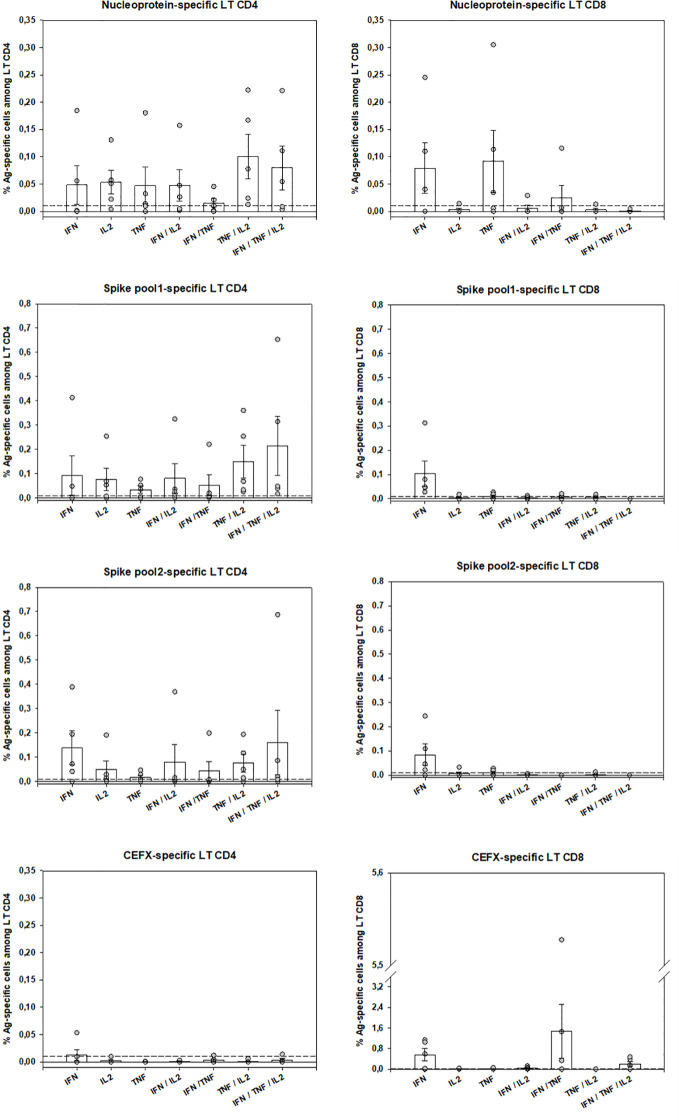
SARS-CoV-2–specific-T-cells numbers and functions. Peripheral antigen-specific CD4 and CD8 T-cells from 5 patients were identified by intracellular staining of IFN-κ, TNF-α and IL-2 by flow-cytometry as described (see Material and Methods and Suppl. Methods sections). Shown are individual data from stimulation with SARS-CoV-2 Nucleoprotein and Spike Glycoprotein peptides pools as well as by multiple immunodominant microbial peptides (CEFX pool) for CD4 and CD8 T-cells and for each cytokine capability (monofunctional, bifunctional or trifunctional). Basal cytokine production of medium-stimulated cells was subtracted for each antigen-stimulated cell subtype and a 0.01% positivity threshold was defined (dotted lines). Bars are shown as mean ± SEM. LT CD4: CD4 T-cells, LT CD8: CD8 T-cells.